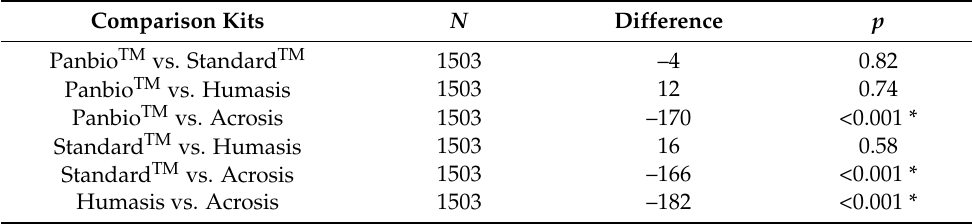
Table 3. Comparison of the true-positive results for RAT kits.